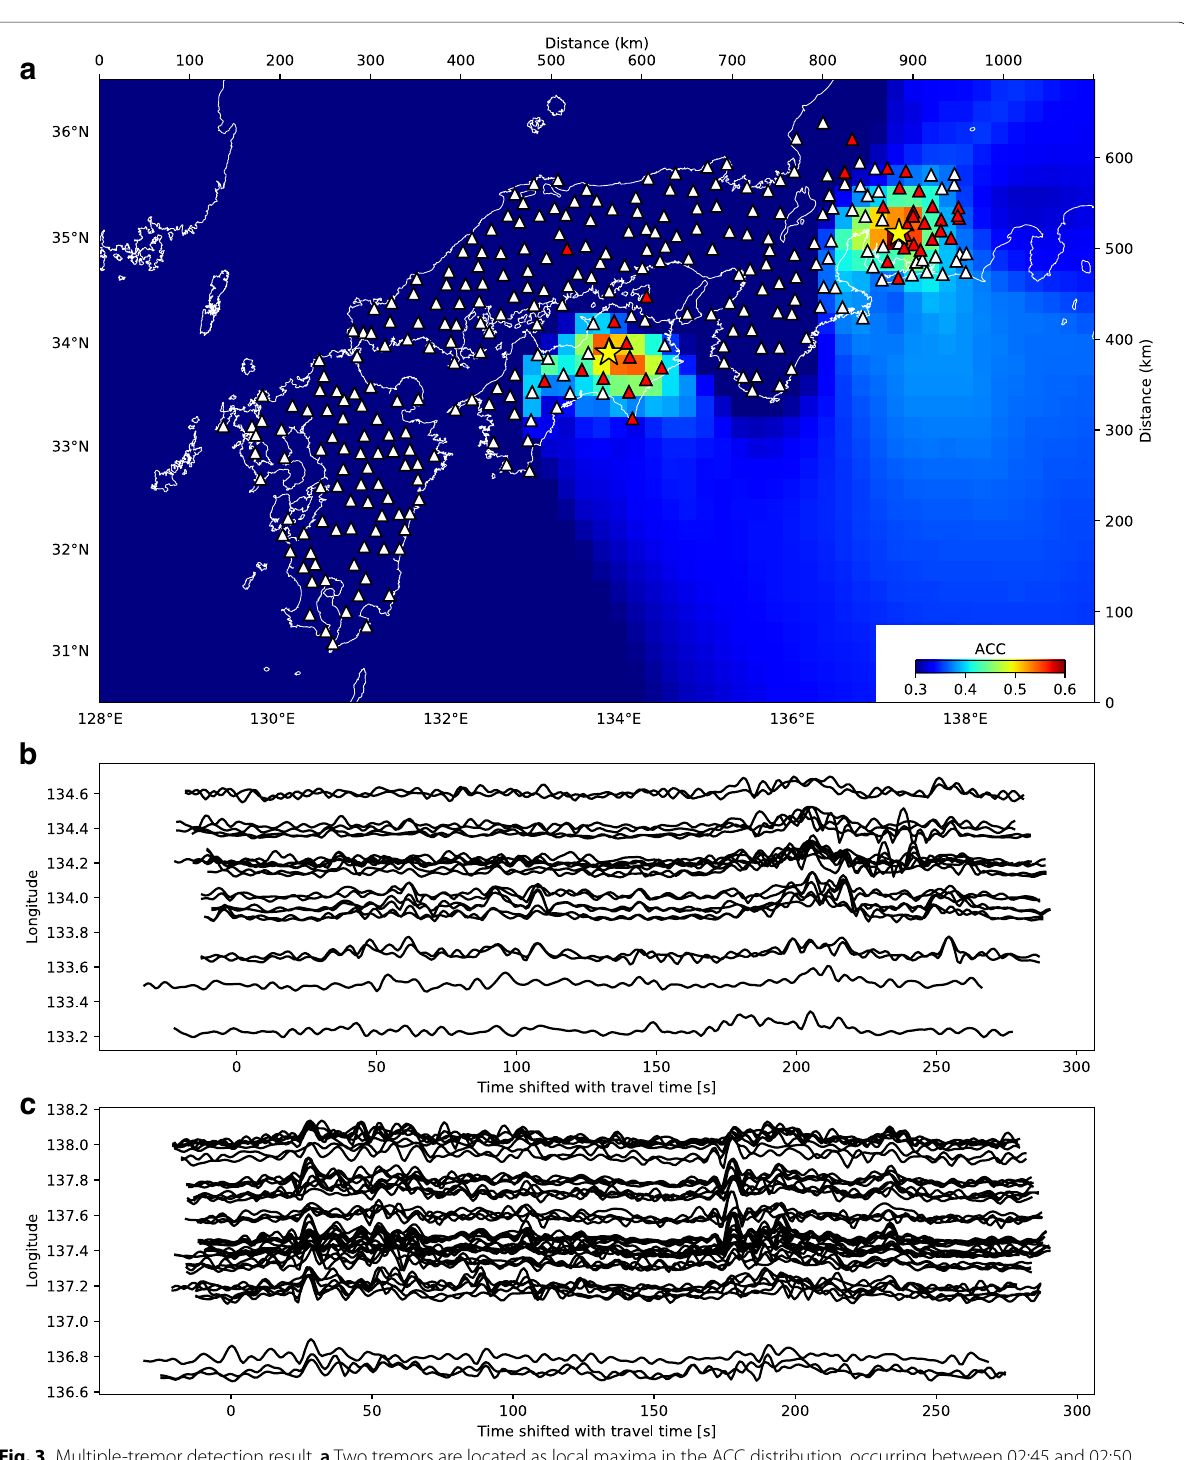
Fig. 3 Multiple-tremor detection result. a Two tremors are located as local maxima in the ACC distribution, occurring between 02:45 and 02:50 on November 16, 2010. The western tremor occurred at 02:48:25, with a hypocentral location of 33.919°N, 133.888°E, and 29.0 km depth. The eastern tremor occurred at 02:45:28, with a hypocentral location of 35.057°N, 137.240°E, and 30.8 km depth. b Normalized envelope waveforms, time-shifted from the western source. The horizontal axis represents time in this time window, and 0 s corresponds to 02:45. c Normalized envelope waveforms, time-shifted from the eastern